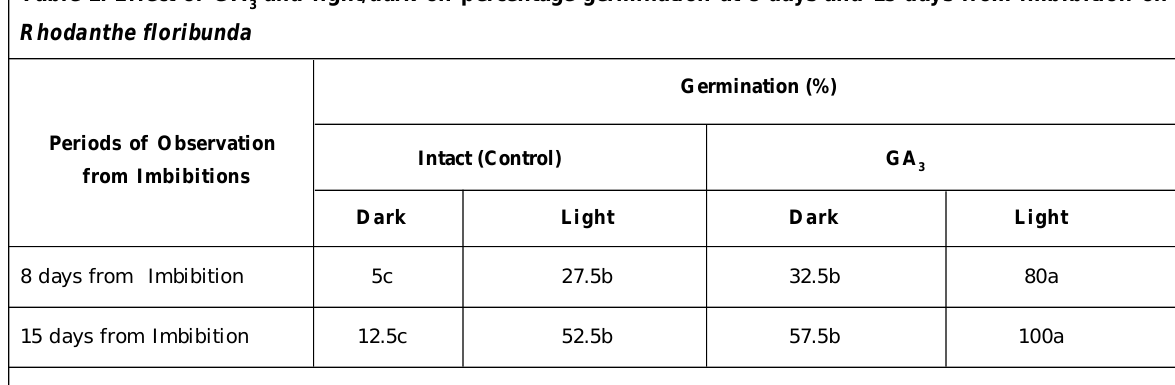
Table 2: Effect of GA and light/dark on percentage germination at 8 days and 15 days from imbibition on 3 Rhodanthe floribunda